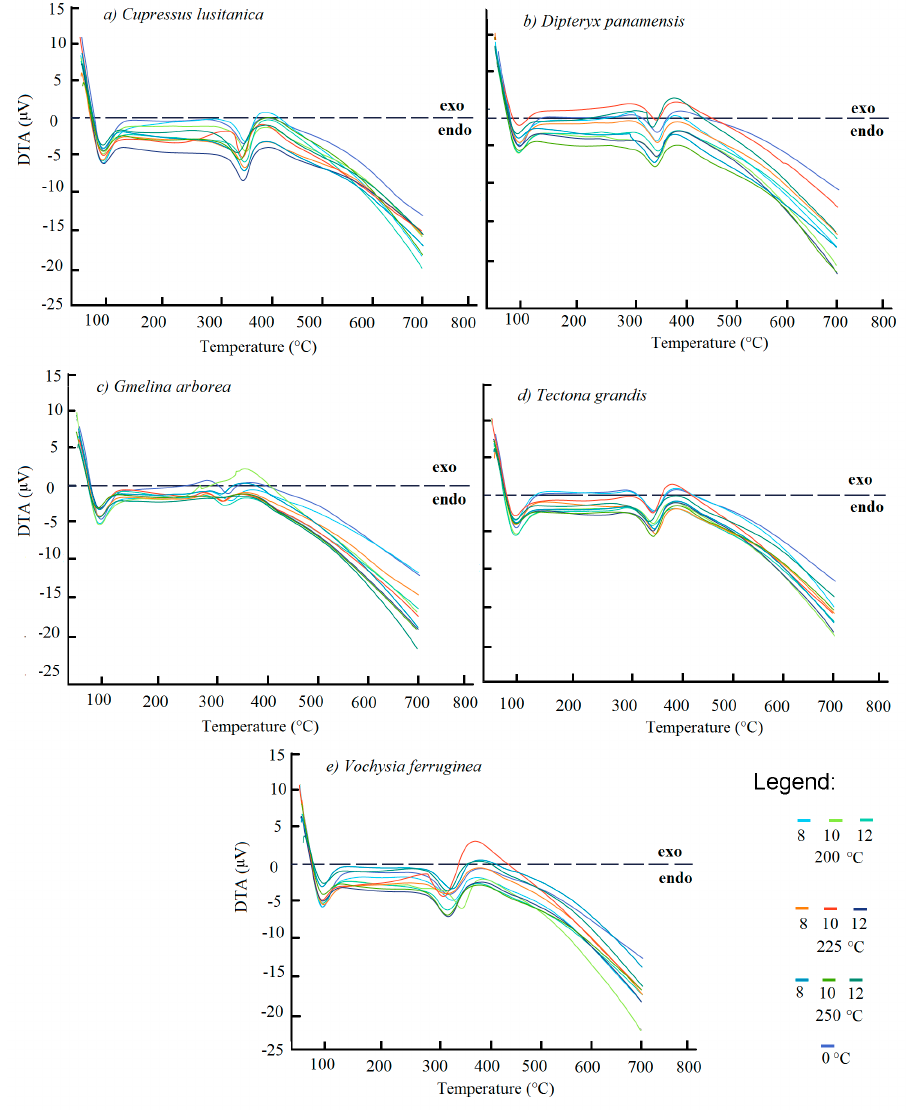
Figure 5. Differential Scanning Calorimetry (DSC) analysis of the torrefaction at different times and temperatures for for ( a ) Cupressus lusitanica , ( b ) Dipteryx panamensis , ( c ) Gmelina arborea , ( d ) Tectona grandis and ( e ) Vochysia guatemalensis .